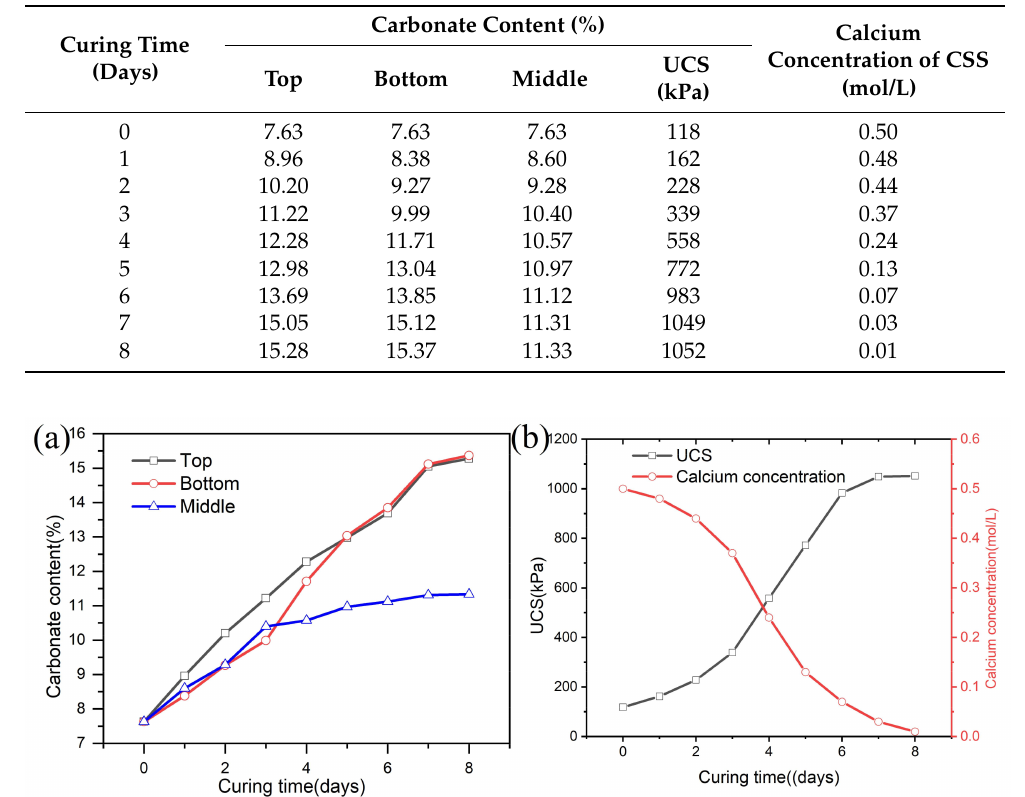
Table 10. The carbonate content, the calcium concentration of the calcium source solution (CSS), and the dry UCS at different curing times.